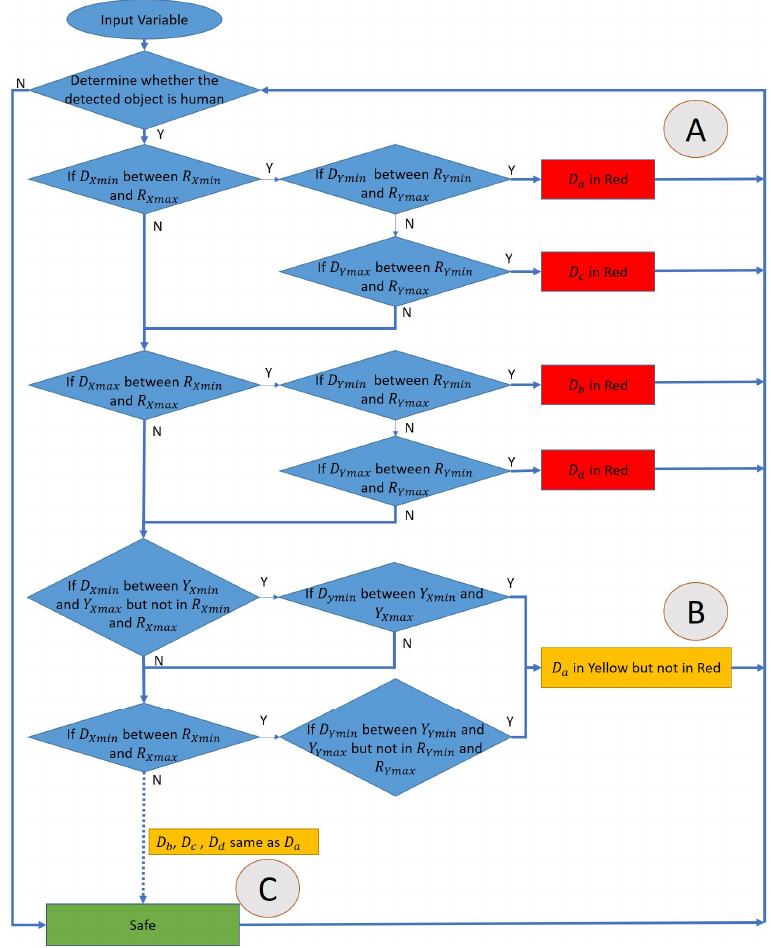
Figure 5. The flowchart of the algorithm.